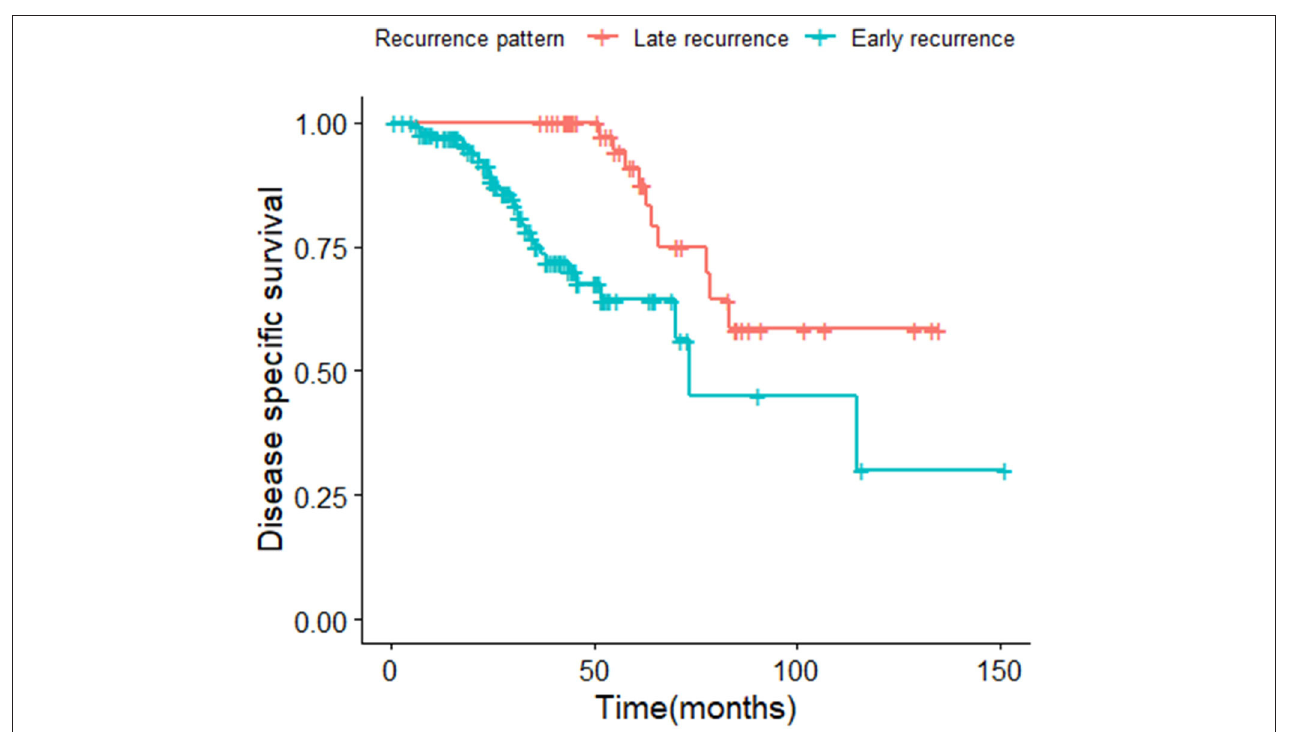
FIGURE 5 | Kaplan-Meier curve of disease specific survival for patients with early and late relapse ( p =